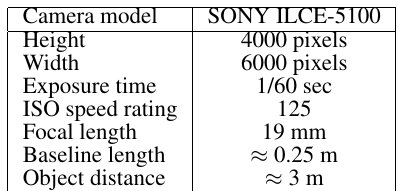
Table 1. Details for acquiring the stereo image pair